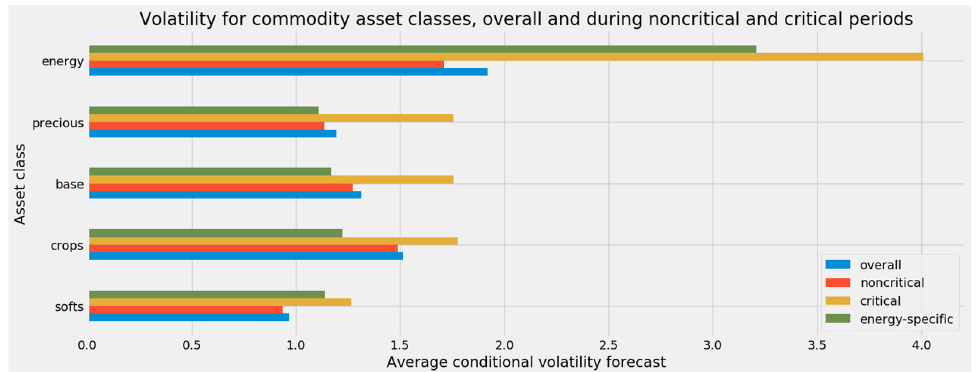
Figure 41. Volatility for commodity asset classes, overall and during noncritical and critical periods.